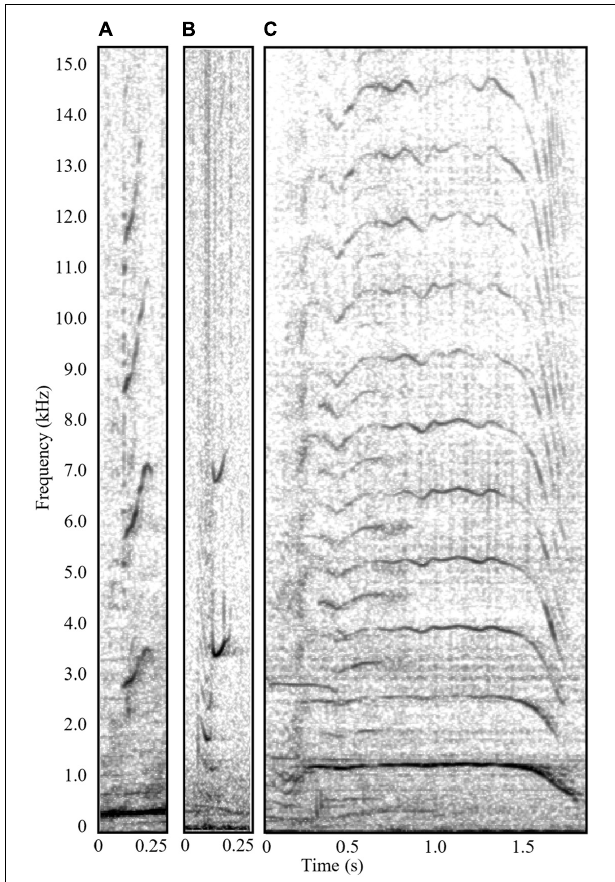
FIGURE 3 | Spectrograms (Hann window, Fast Fourier Transform 4096 samples, overlap 90%) of the relatively high frequency call types detected in competitive groups during this study: (A) “harmonic squeak,” (B) “chirp,” and (C) a high frequency “song unit social call.” Sound clips can be found in Supplementary Material .